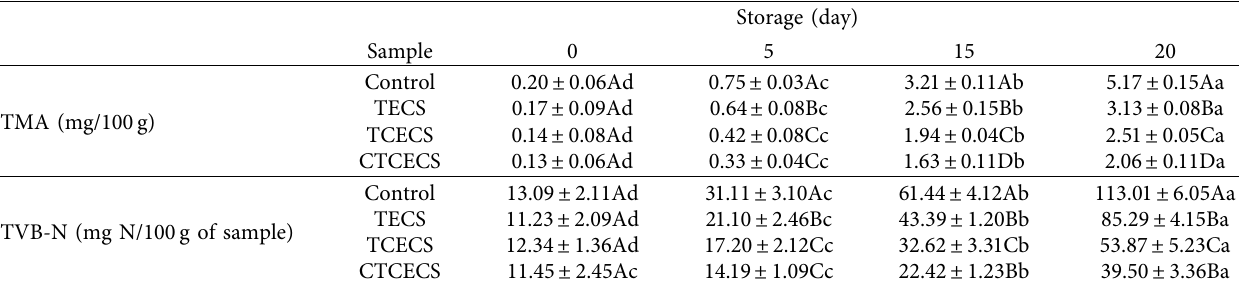
Table 3: Changes in TMA and TVB-N values of rainbow trout fillets during storage at 4 ± 1 °